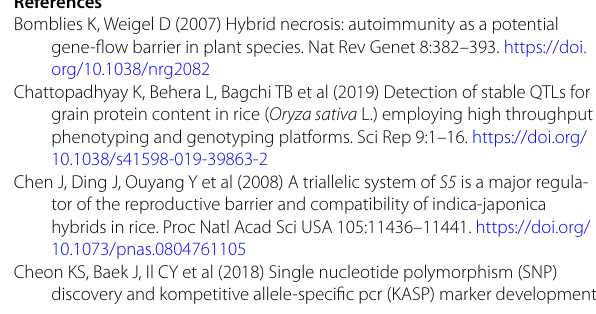
performed to select promising advanced backcrossed lines, and the lines were subjected to a bioassay for bacterial blight, BPH and blasts. Figure S2 . Correlation efficiency of five R ‑genes related to the spikelet fertility of the tested lines. Table S1 . ANOVA of resistance genes and their interac‑ tions on spikelet fertility. Table S3 . Substituted chromosome segments from donor parents in gene pyramided lines by KASP marker analysis. Figure S3 . Notched box plots for spikelet fertility (SF) of lines grouped by each QTL‑QTL combination. The different letters show significant differ‑ ences in SF among the tested lines based on Duncan’s multiple range test. Means followed by the same letter are not significantly different at the 5% significance level. Table S4 Epistatic interactions among major effect loci of spikelet sterility. Figure S4 . Pollen grains obtained from the parents, sterility, and fertility lines at the flowering stage. Pollen grains were stained with 1% iodine‑potassium iodide (I2‑KI) on glass slides. Scale bars Figure S5 . Graphical genotype of the parents, Jinbu (P1) and GPL (P2) using KASP marker set. The horizontal lines on each chromosome of P2 indicate sites of segments introgressed from R‑donor lines. Genetic back‑ ground of both was derived from Jinbu. The five R‑genes were marked in the box on the chromosome of P2.